Question: Identify the chart type used in this figure.
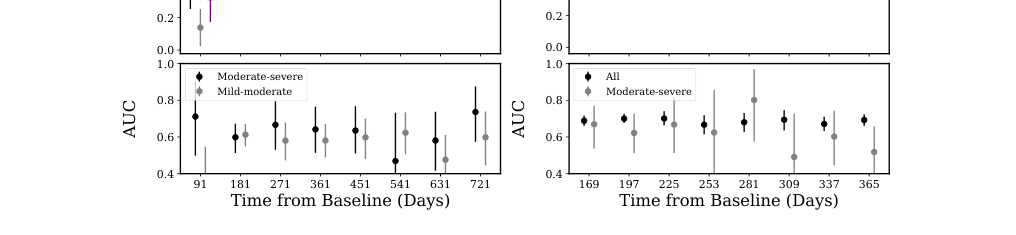
Answer: bar